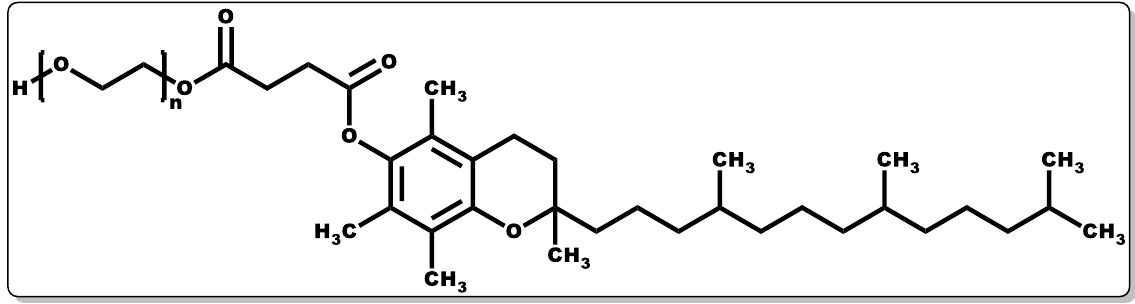
Figure 10. Structure of α -tocopheryl polyethene glycol 1000